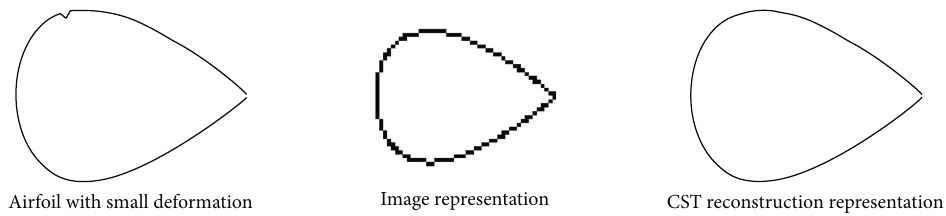
Figure 1: Airfoil with small deformation, its image representation, and CST reconstruction representation.